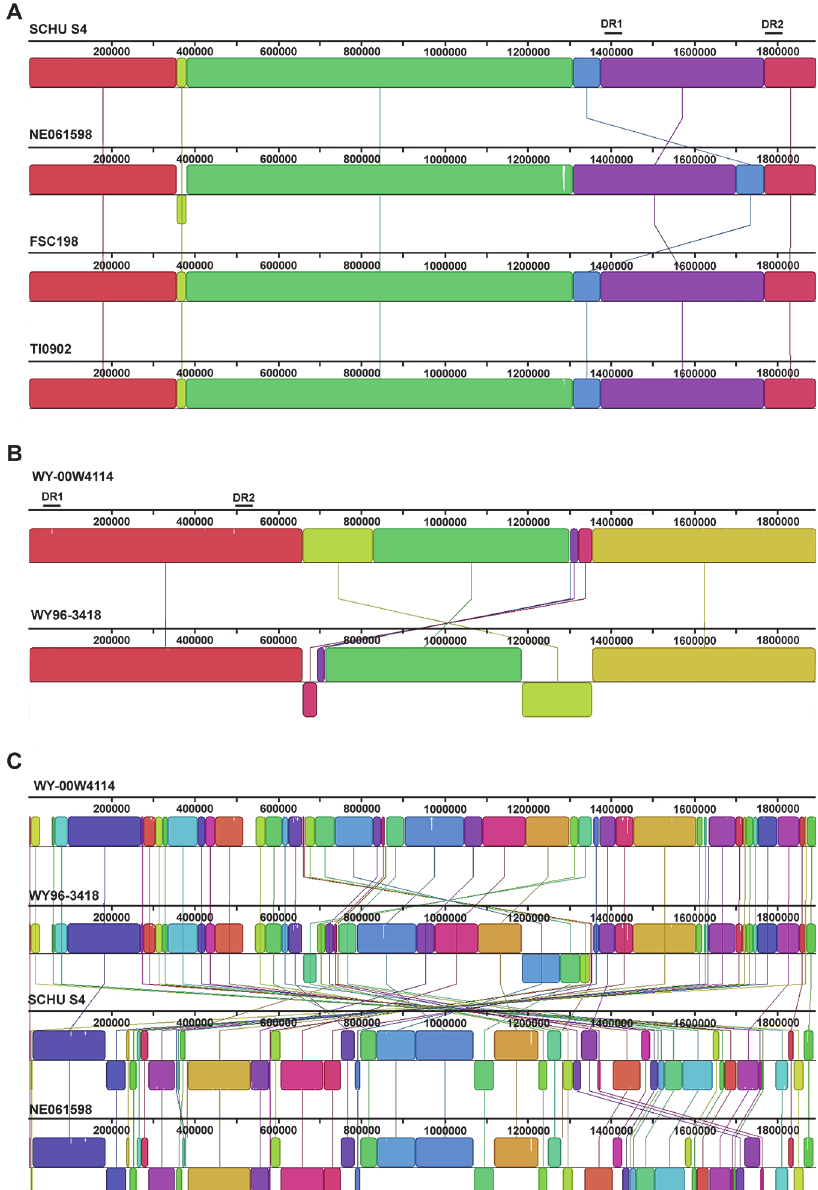
Fig 4. Genome alignment of F . tularensis A.I and A.II strains. Chromosomal alignments of representative F . tularensis A.I strains SCHU S4, NE061598, FSC198, and TI0902 (A); pairwise genome alignment of the F . tularensis A.II strains WY-00W4114 and WY96-3418 (B); and multiple chromosomal alignment of the F . tularensis A.I and A.II strains sequenced to completion and shown in panels A and B (C) . The relative location of the Francisella pathogenicity island (FPI) in duplicated region 1 (DR1) and duplicated region 2 (DR2) is identified with a bar above the associated chromosomal region for each subtype. The progressiveMauve software tool was used to align the genomes